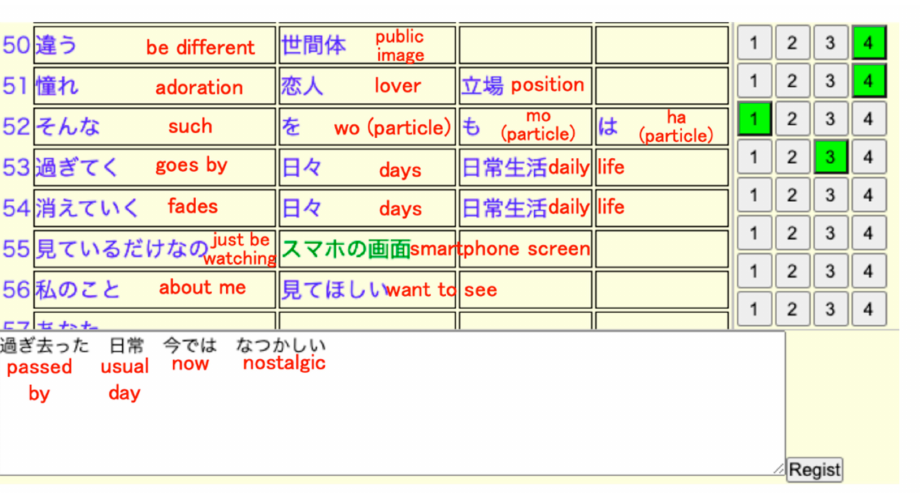
Figure 3. A text input area at the bottom of the lyric editing window. (The blue texts in the lyric candidate sentence display area are the Japanese lyric keywords entered by participants C and D in Table 1. The black texts in the text input area are the Japanese lyric keywords entered by the authors. The authors added English translations of the Japanese texts in